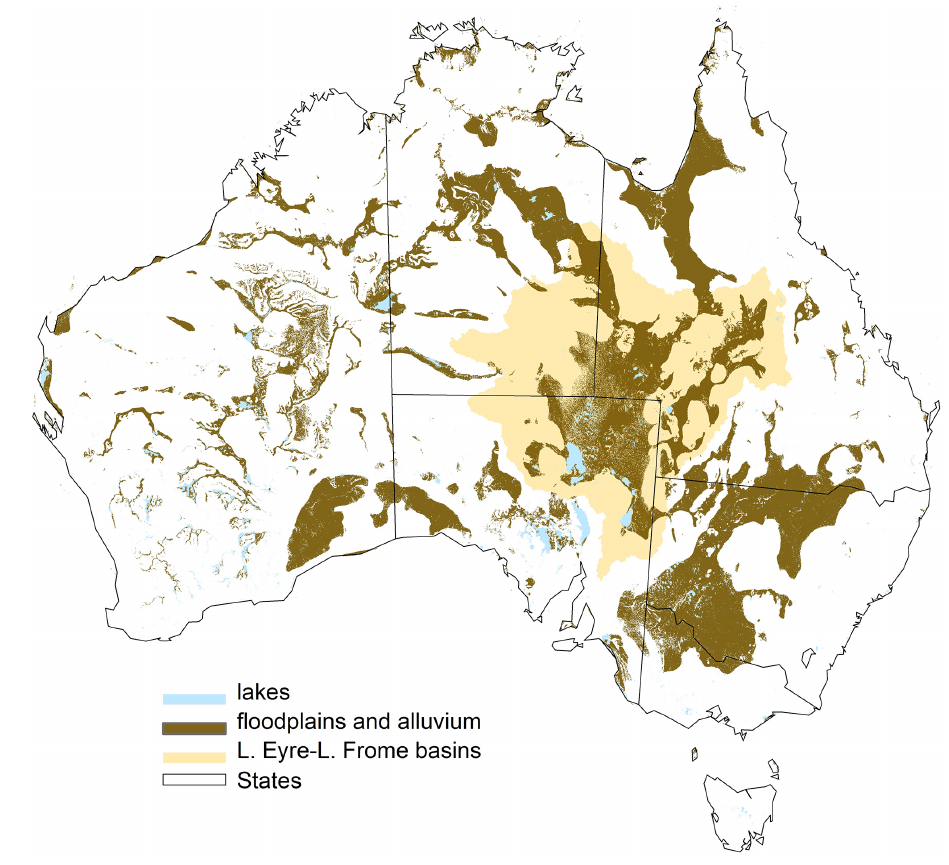
Figure 1. Map showing net deposition relative to floodplains and alluvial flats as mapped by Gallant and Dowling